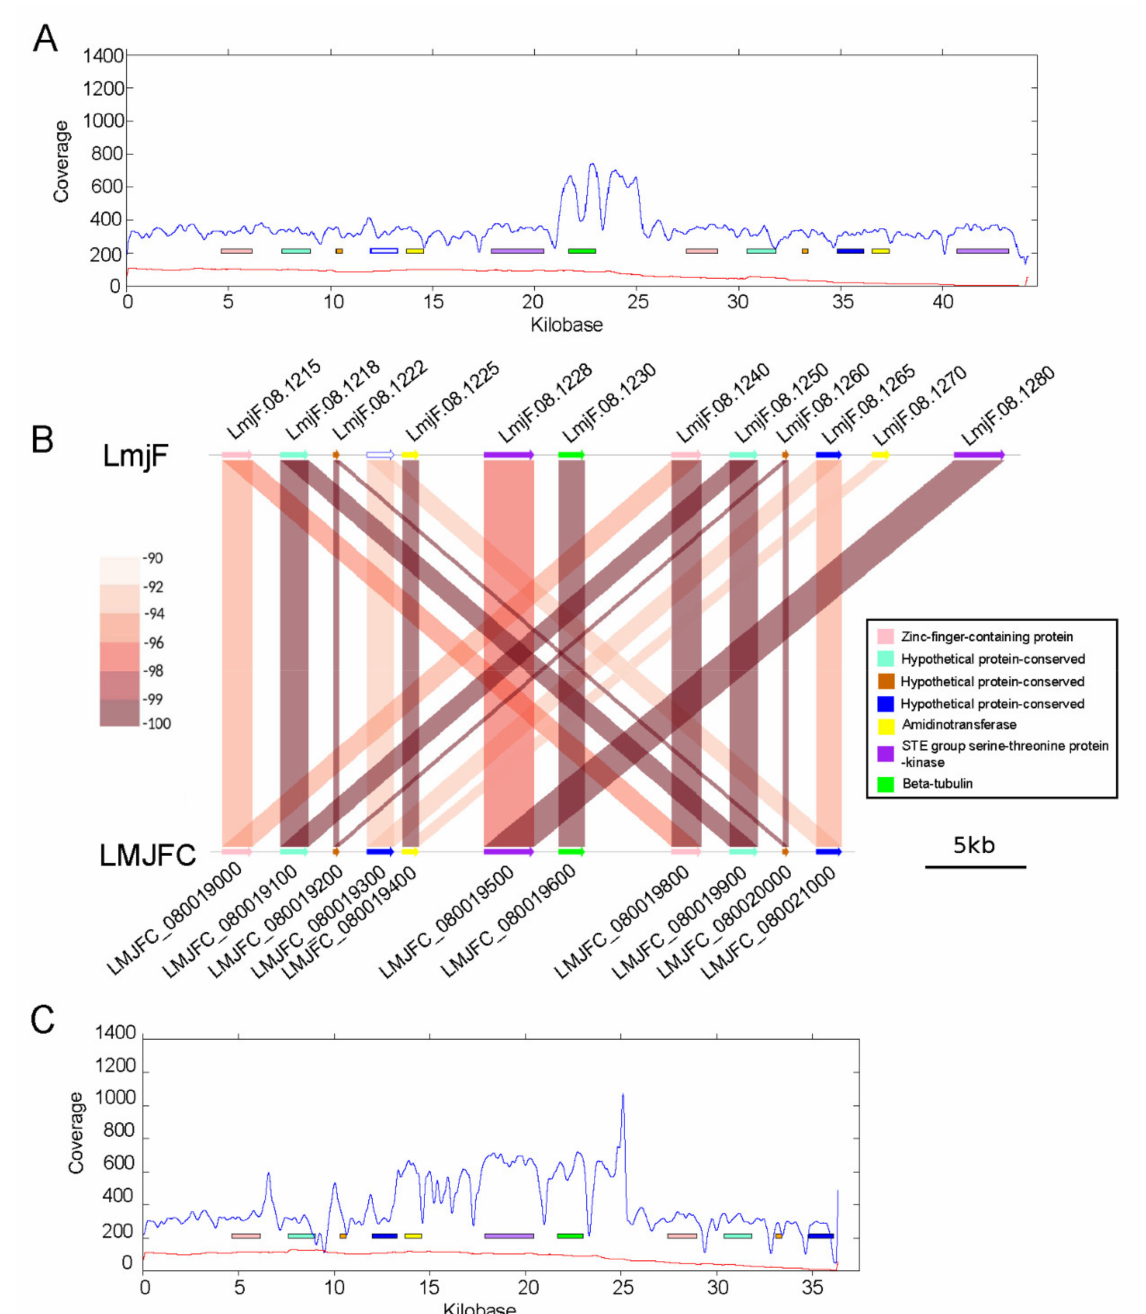
Figure 6. The right end of chromosome 8 has not been assembled in a definitive manner. ( A ) Linear coverages of Illumina reads (in blue) and PacBio reads (in red) mapped to this chromosomal region in the LmjF assembly. ( B ) Schemes show the gene organization and sequence identity of the genes annotated at the right end of chromosome 8 in the LmjF and LMJFC assemblies. Gene sequence identity is shown according to a color-intensity scale (brow hue ranges from 90 to 100% of sequence identity). ( C ) Linear coverages of Illumina reads (in blue) and PacBio reads (in red) mapped to this chromosomal region in the LMJFC